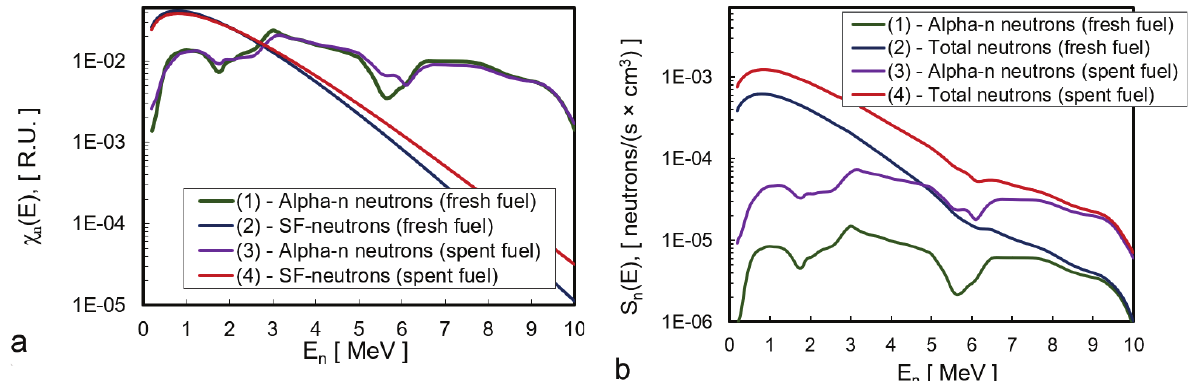
Figure 4. The neutron component of the radiation characteristics of the IVG.1M reactor fuel: a. The normalized distribution of neu- trons (1 – (α, n)-neutrons of fresh fuel; sf -neutrons of fresh fuel; 3 – (α, n)-neutrons of irradiated fuel; 4 – sf -neutrons of irradiated fuel); b. The neutron spectrum (1 – fresh fuel; 2 – irradiated